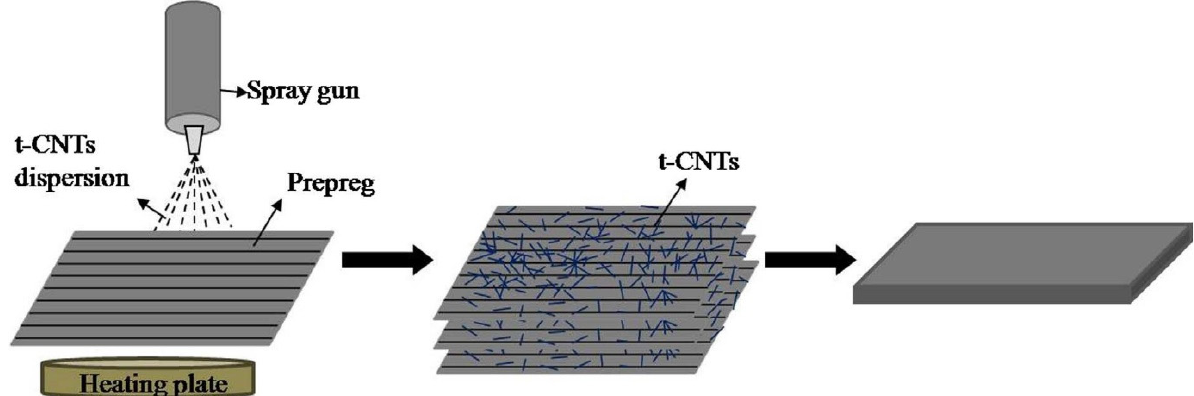
Figure 7. Preparation of CF/CNT/PEEK multiscale composite using spray gun technique (reprinted with permission) [51].